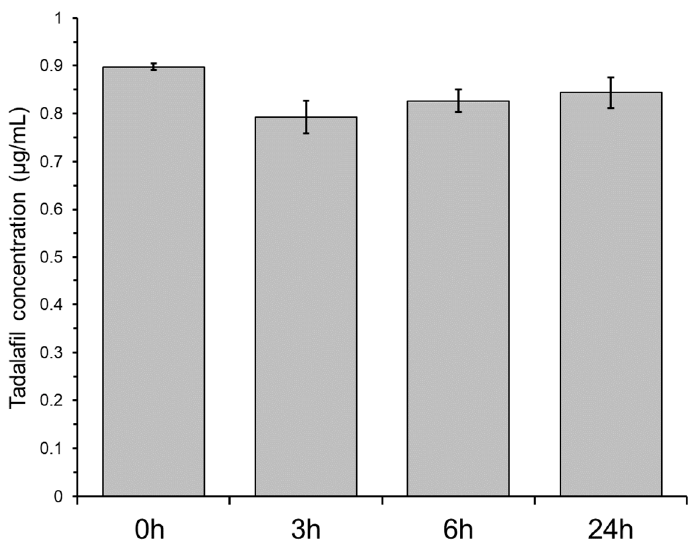
Figure 4. Non-specific adsorption of tadalafil to the plastic material of the two-compartment microplate system shown as the tadalafil concentration in the bottom-well after 3, 6 and 24 h incubation of a 0.9 µg/mL tadalafil solution. ‘0 h’ indicates the ‘unincubated’ (start) concentration. Data shown as mean ± SD of six replicates.